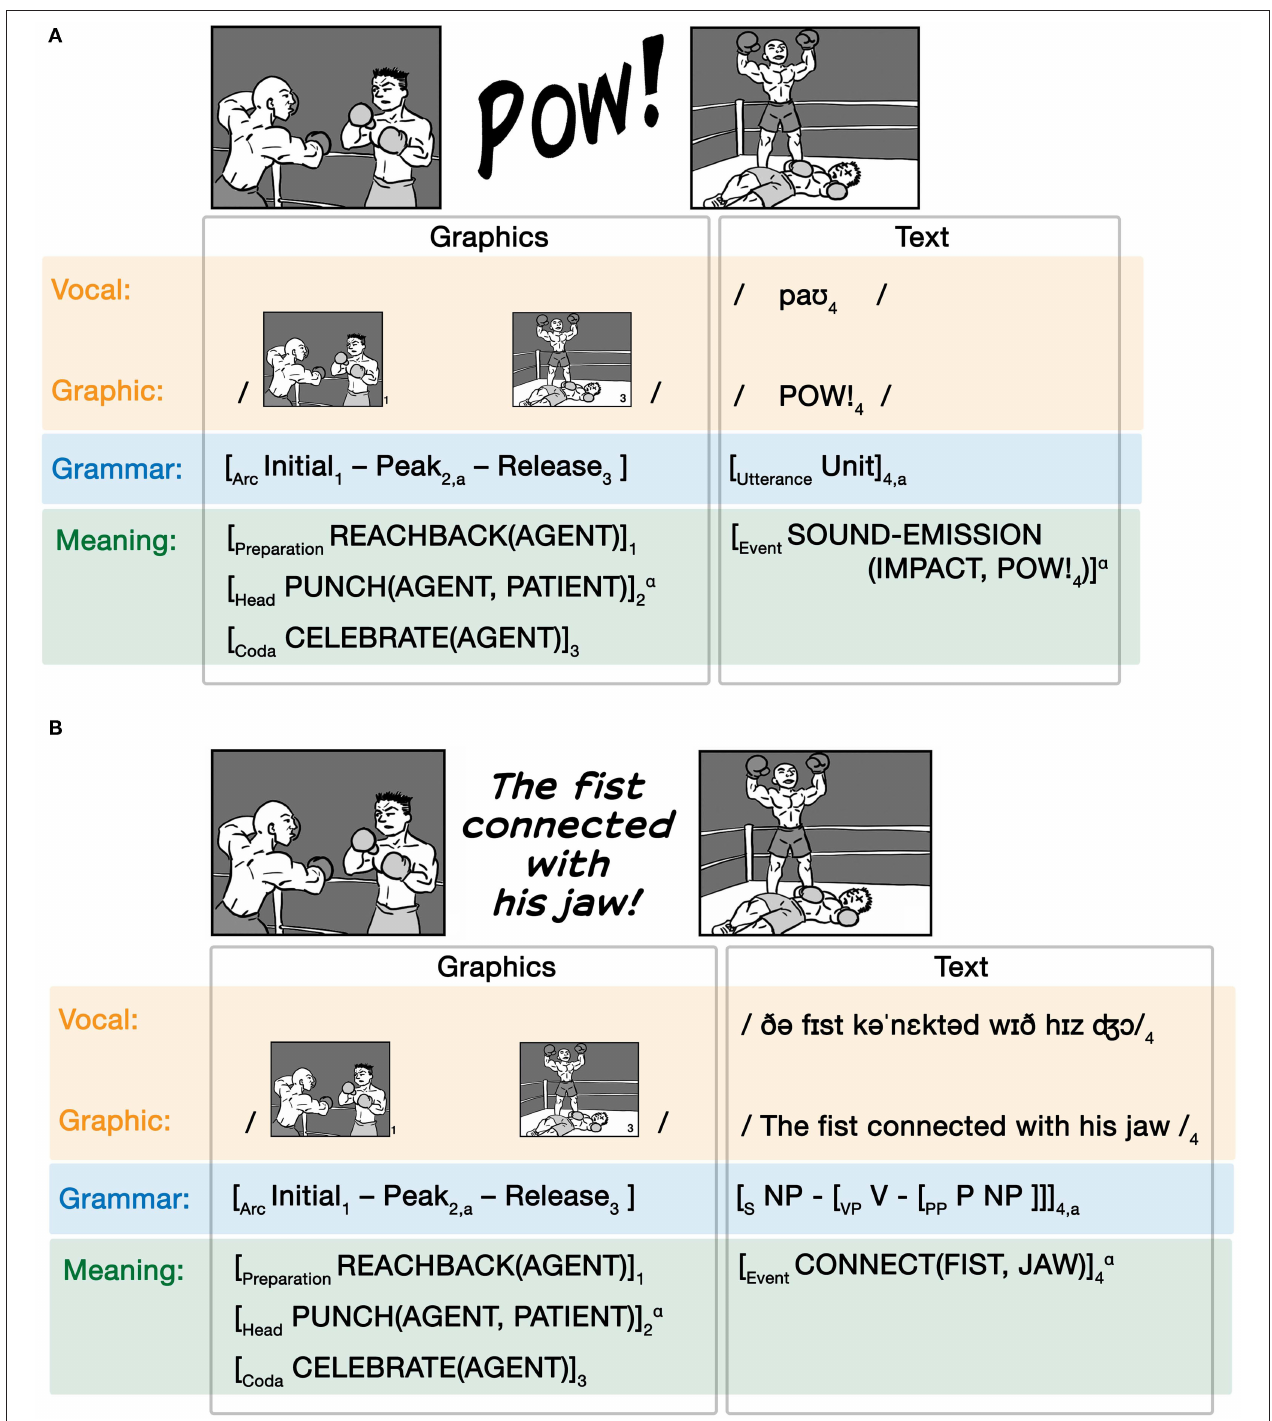
FIGURE 9 | Substitutive grammatical interactions between a visual narrative sequence and (A) an onomatopoeia and (B) a sentence.